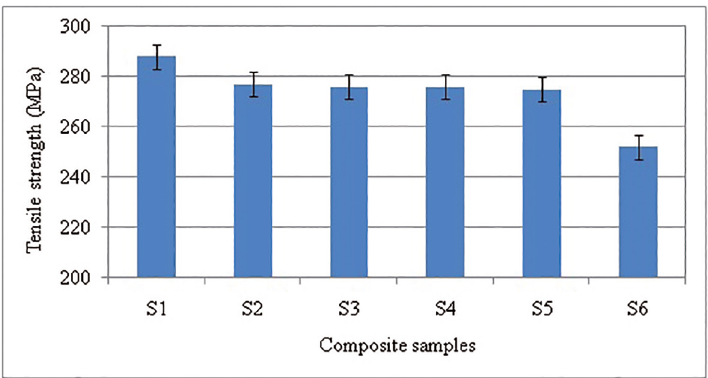
Figure 9: Tensile strength comparison of carbon/banana fiber reinforced hybrid composites fiber reinforced epoxy composites are performing better than the other composite combinations tested. This is higher than that of the average tensile strength for banana/glass fibers reinforced hybrid composites 38,39